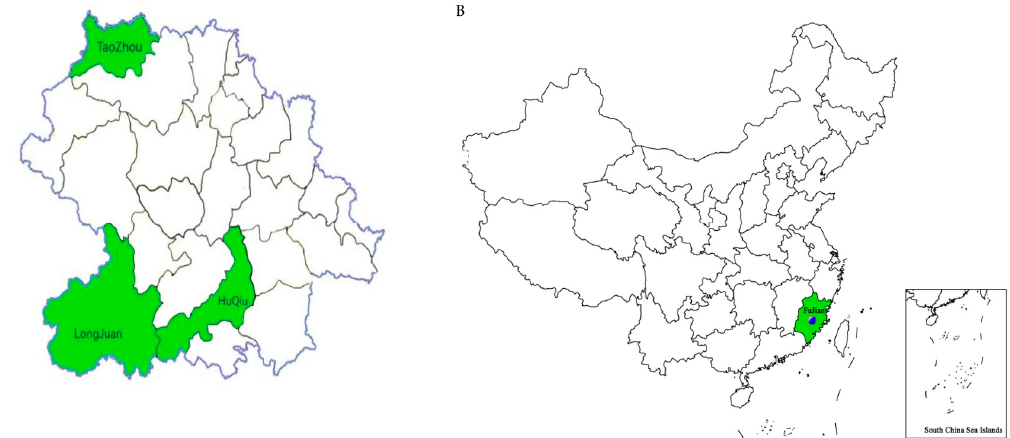
Figure 1. The map showing the geographical distribution of the three experimental sites located in Anxi county, China. ( A ) Location of the experimental sites in Anxi county. ( B ) Location of Anxi county in China. Adobe Illustrator Artwork 17.0 software was used to create the map.